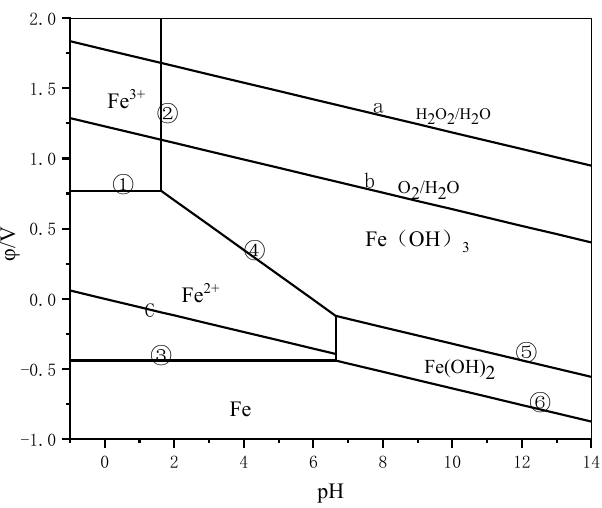
Figure 1. Fe-H 2 O system φ -pH (normal temperature 25 °C). Figure 1. Fe-H ϕ -pH (normal temperature 25 ◦ 2 O system